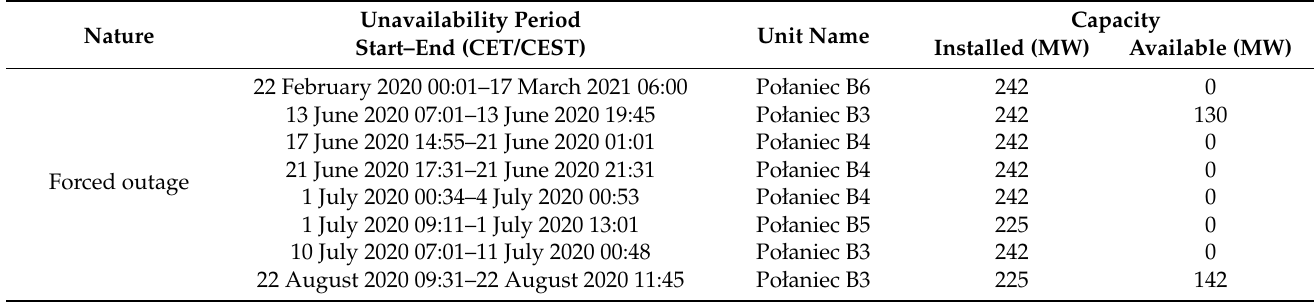
Figure 20. Diagram of water temperature in the Wisła River (Szczucin) and air temperature. Table 6. Power losses in the Połaniec power plant, June–August 2020